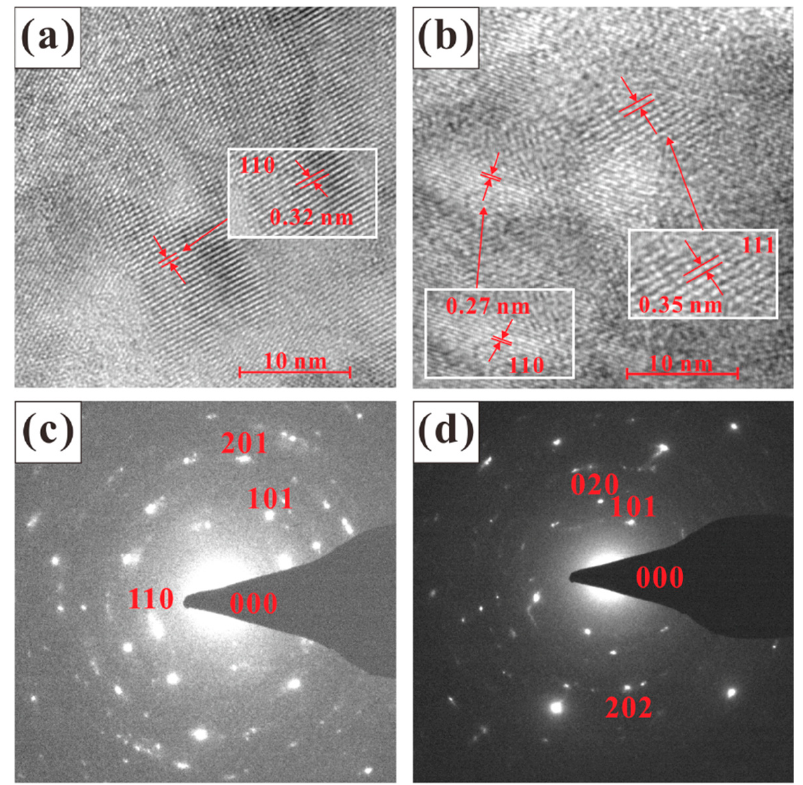
Figure 6. ( a , b ): high-resolution transmission electron microscopy (HRTEM) images of the starting and recovered samples, respectively. ( c , d ): the corresponding selected area electron diffraction (SAED) patterns.